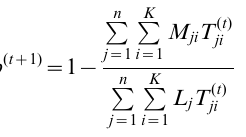
For this mixture model, the expectation maximization (EM) algorithm [17] is used to calculate the maximum